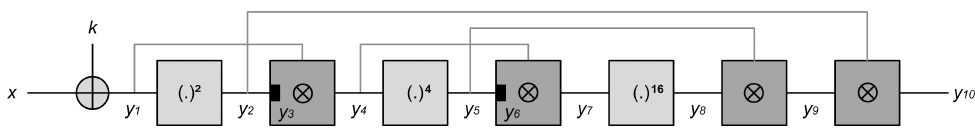
Figure 16: AES S-box from [RP10] (black rectangles are refreshing gadgets from